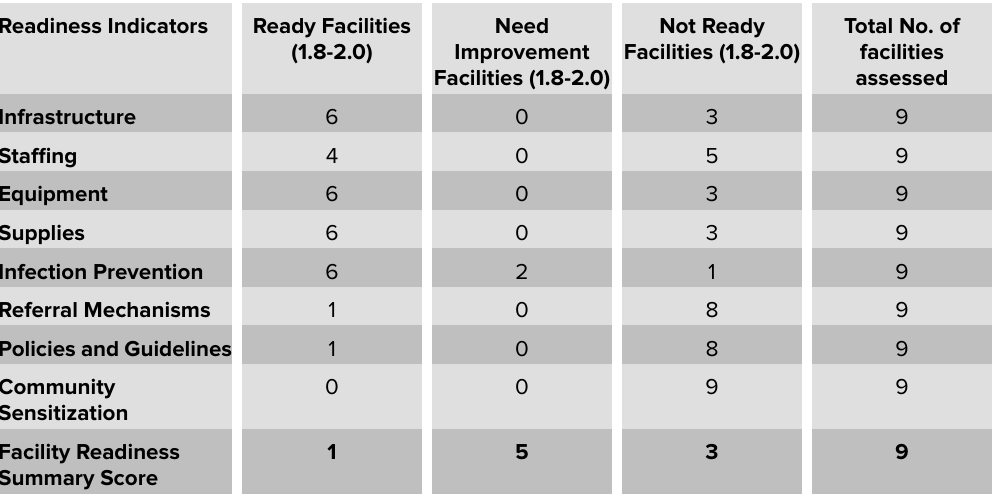
TABLE 2: Distribution of cervical cancer centers according to facility readiness category scores: Diagnostic/treatment (colposcopy)